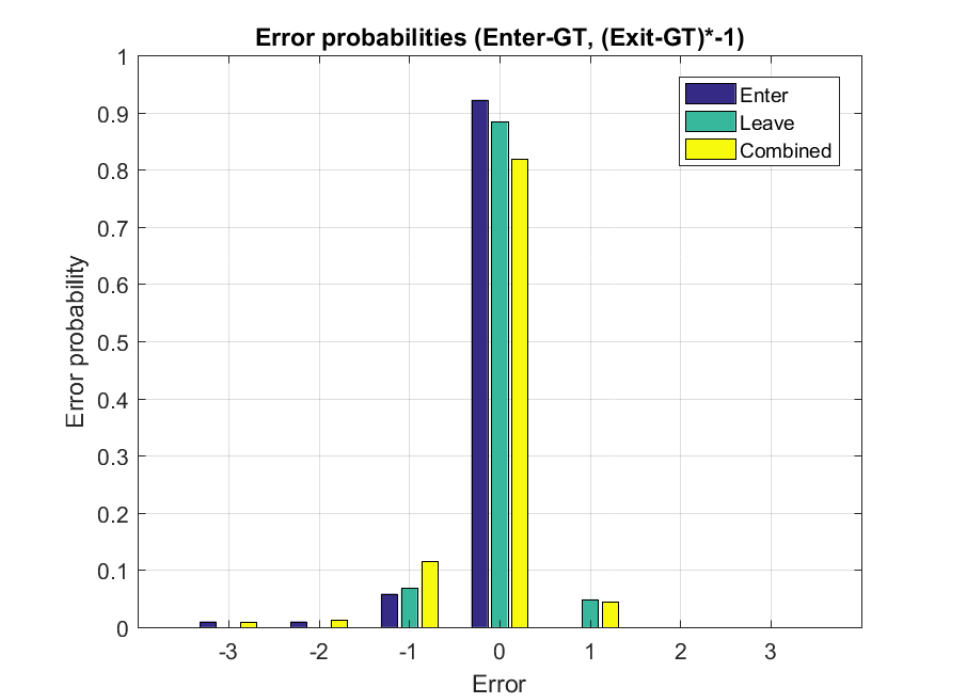
Figure 6. Probabilities of enter and exit event errors, and of combined events. Note: in order to combine enter and exit event errors, exit events must be multiplied with − 1 before calculating probabilities, as exit events are people leaving the bus. The expected combined error: − 0.1237. The empiric distribution was obtained from data sets 1 and 2 (DS1 and DS2).